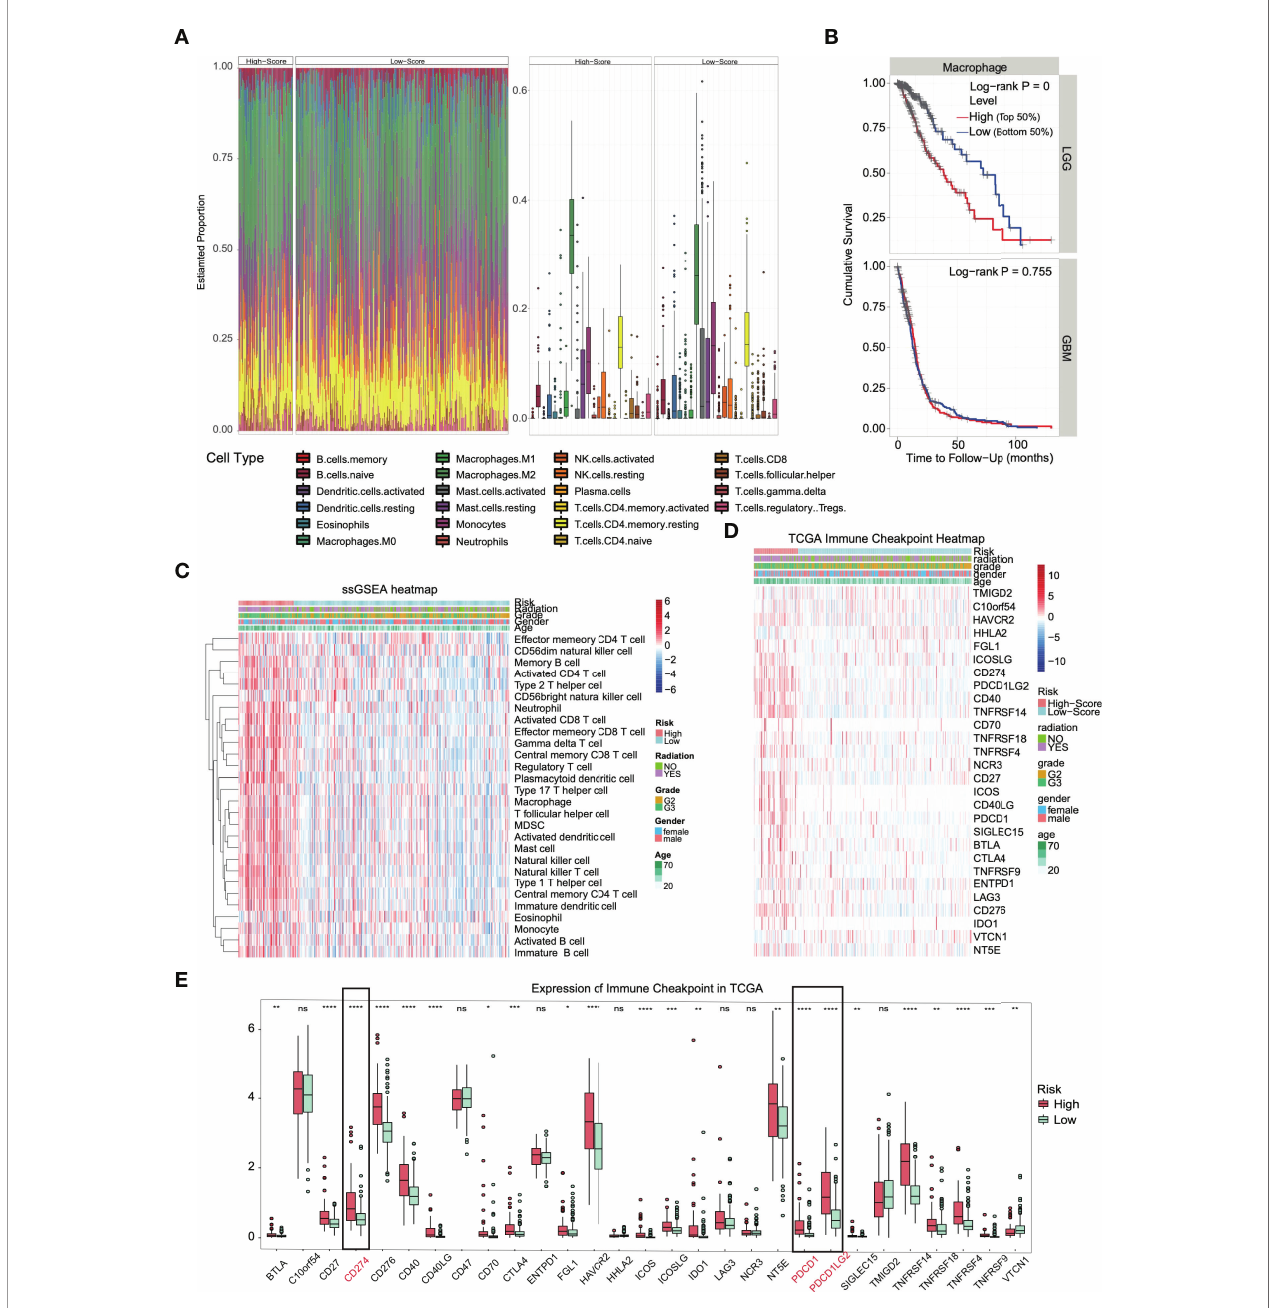
FIGURE 6 | Immune in fi ltration and immune checkpoint expression in the high-risk group. (A) Heatmap and boxplot of the CIBERSORT algorithm evaluating the proportion of 22 kinds of immune cell in fi ltration in high- and low-risk solid tumors. (B) The proportion of macrophage in fi ltration was signi fi cantly correlated with the overall survival time of patients with low-grade glioma. (C) Heatmap of the immune cell in fi ltration landscape in high- and low-risk solid tumors using the ssGSEA algorithm. (D) The heatmap integrated the clinical features and the expression of the immune checkpoint in the TCGA dataset. (E) In TCGA datasets, most of the immune checkpoints were activated in high-risk groups. *p < 0.05, **p < 0.01, ***p < 0.001, ****p < 0.0001, ns. (no signi fi